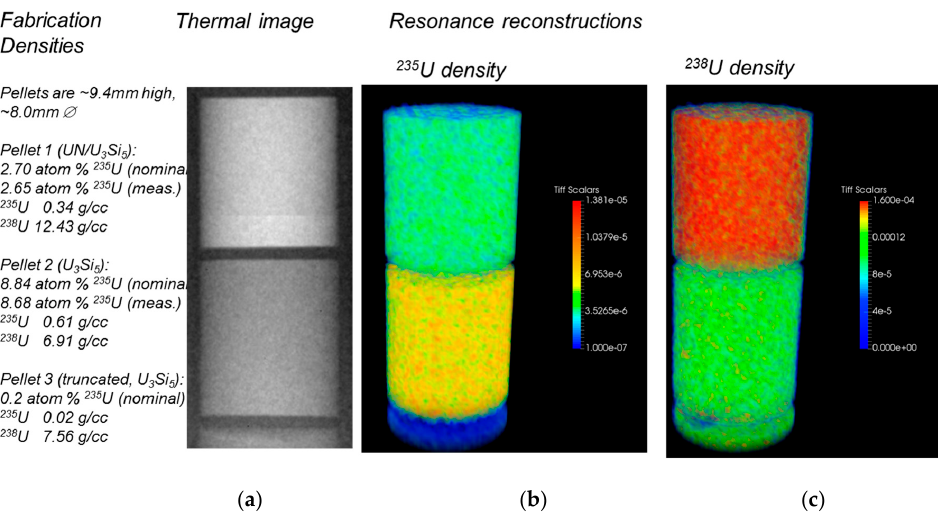
Figure 8. Neutron computed tomography (CT) of UN/U 3 Si 5 and U 3 Si 5 fuel pellets with different enrichment levels. While the thermal neutron tomography ( a ), as available at a reactor, does not distinguish the differences in enrichment levels of the middle and lower pellet (8.84% and 0.2% enrichment, respectively), the reconstruction of 235 U ( b ) and 238 U ( c ) densities clearly provides this information.